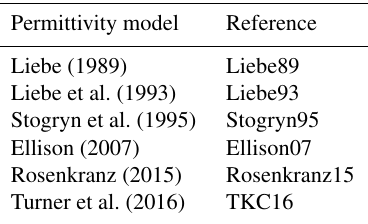
Table 1. List of different liquid water permittivity models and how they are referenced within this